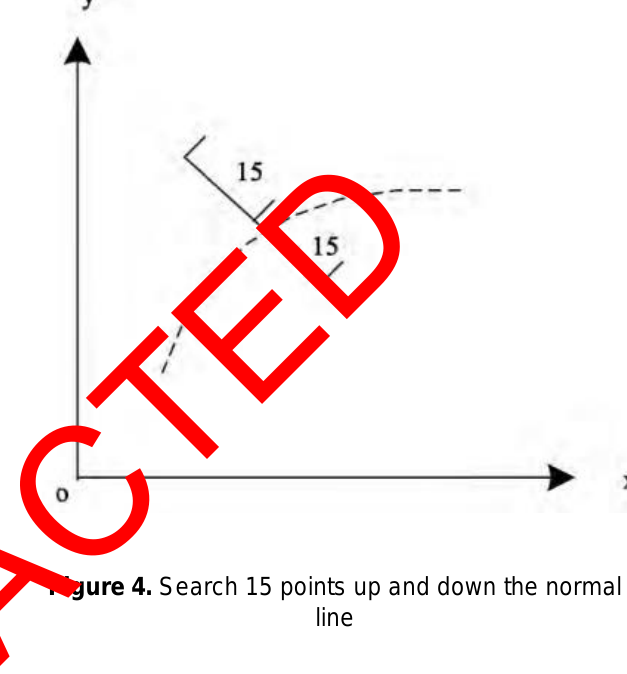
Figure 4. Search 15 points up and down the normal